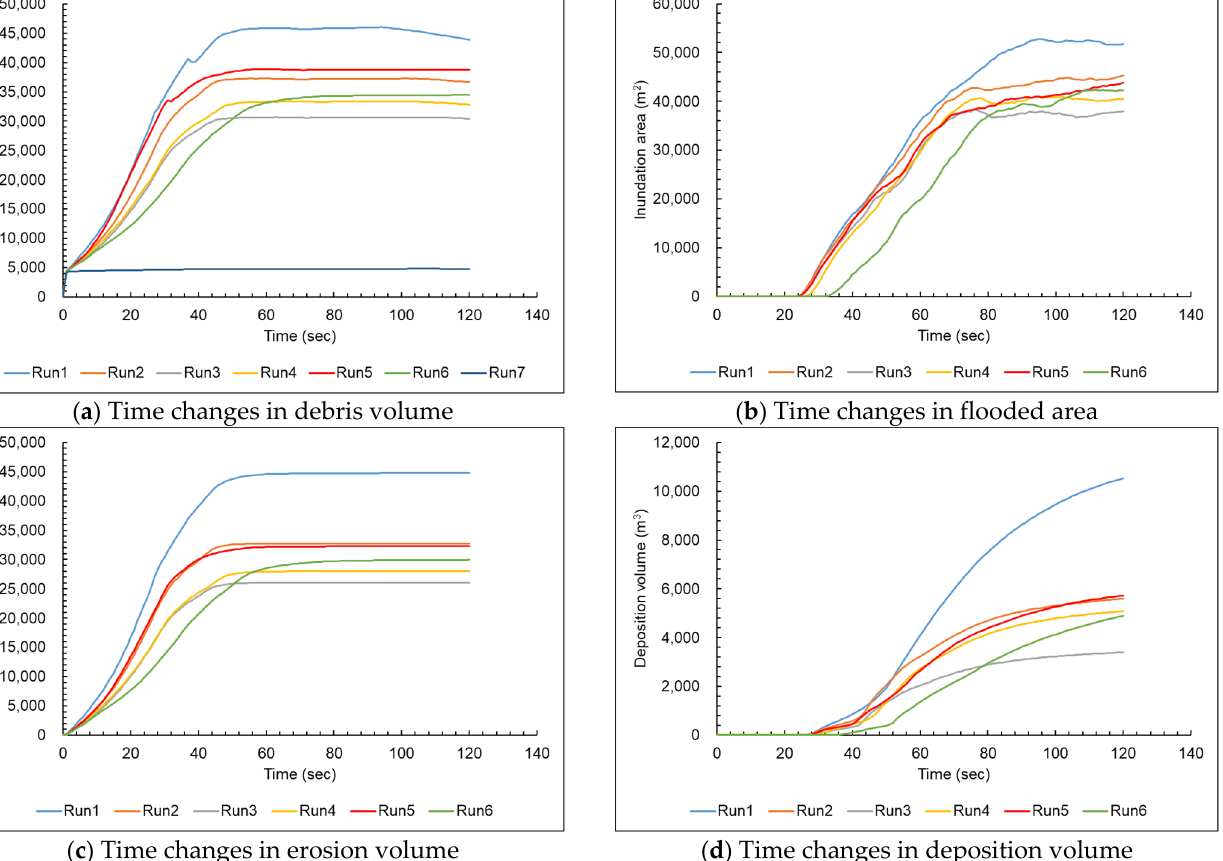
Figure 9. Time changes in simulation result from entrainment phenomena.